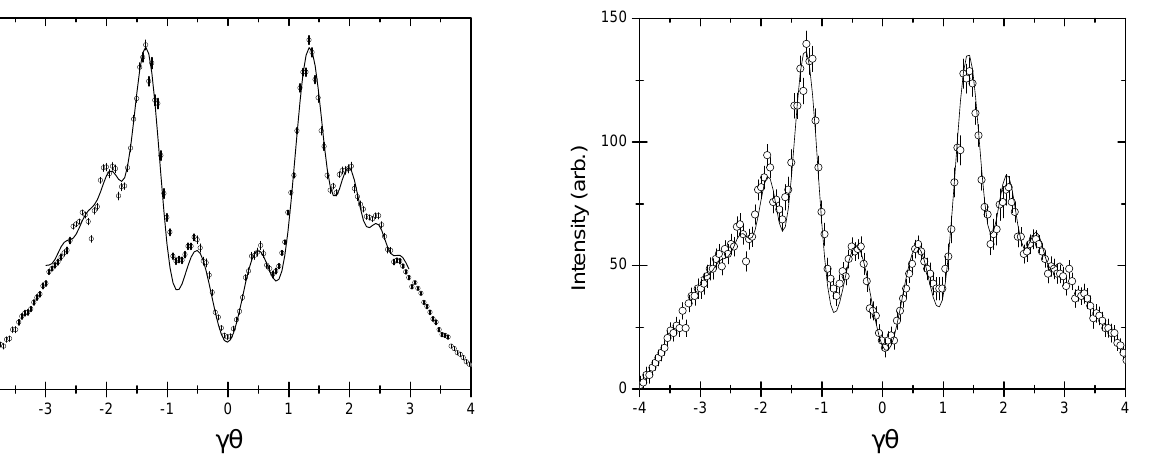
FIG. 7. Whole-beam OTRI fit to 0.85 mrad divergence. FIG. 8. Beam-core fit to 0.68 mrad